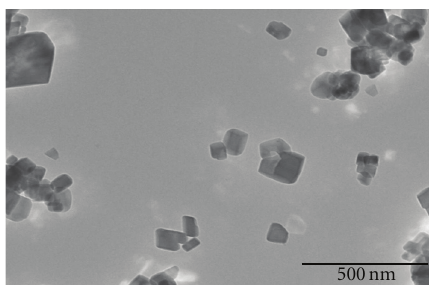
Figure 6: TEM Image of nano-CaCO 3 synthesized using hydrody- namic cavitation (4mm orifice, 4% Ca(OH) 2 slurry, 5l/min, CO 2 flow rate) (Scale 500nm).